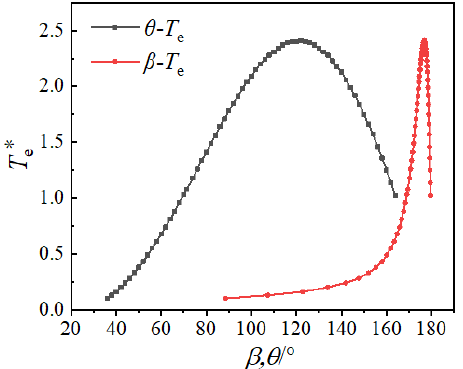
Figure 4. The θ-T e and β-T e curves with per unit value. Figure 4. The θ - T e and β - T e curves with per unit